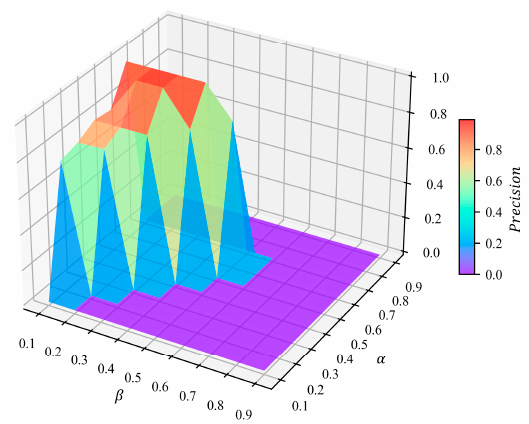
Figure 6. Mushroom’s Precision change chart.